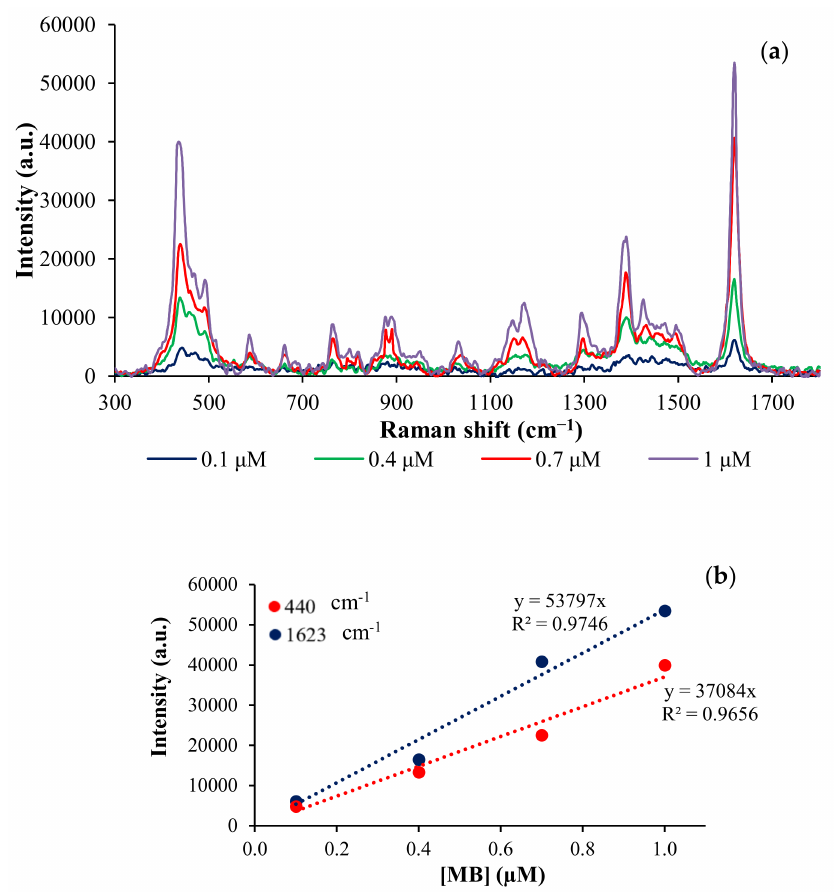
Figure 4. ( a ) SERS spectra of MB with di ff erent concentration: 0.1 (blue), 0.4 (green), 0.7 (red) and 1 µ M (violet), using AgNPs-39 as SERS substrate, ( b ) calibration curve of SERS intensity at 440 and 1623 cm − 1